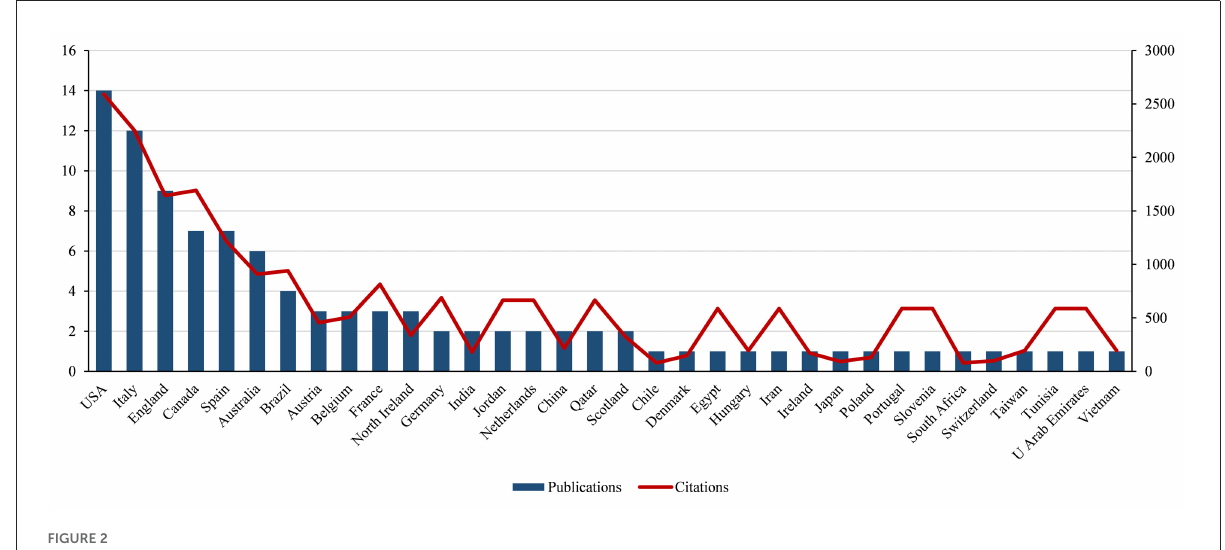
FIGURE2 Number of top-cited articles by